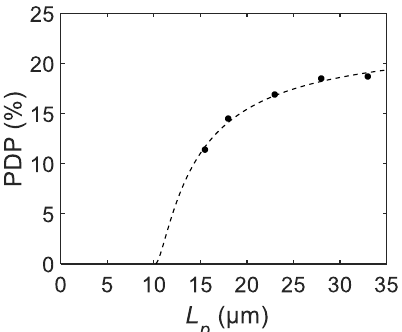
Figure 10. The measured PDP trend from the literature fitted by the theoretical equation [40]. The measured and fitted data are shown as dots and a dashed line,